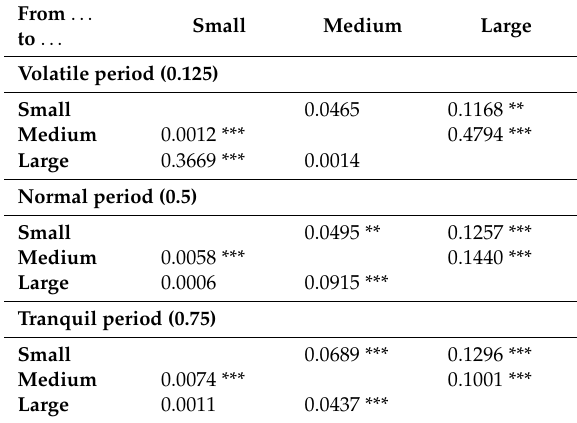
Table 3. Spillover coe ffi cients of the SDSVaR model, based on the total assets measure of the size. From ...